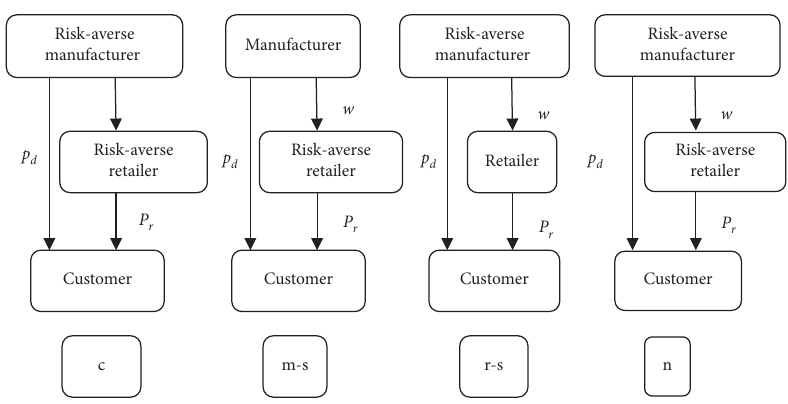
Figure 1: The structures of the dual-channel supply